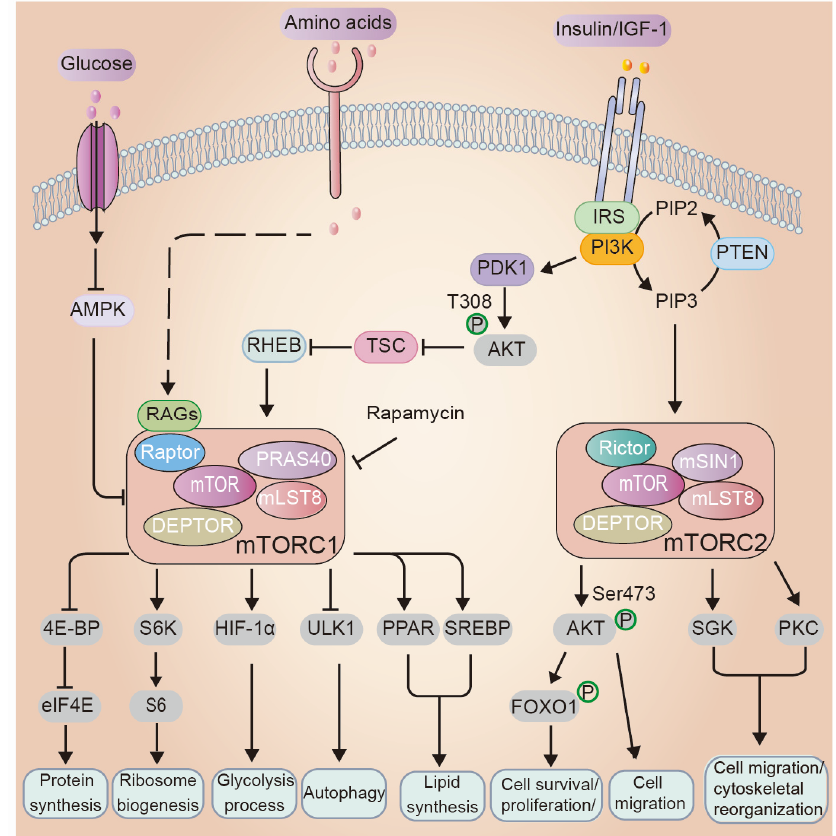
Figure 2. Overview of mTOR signaling network. Amino acids, growth factors, oxygen and the cellular energy are the major inputs inducing mTORC1 activity. Upon stimulating by the growth factors such as insulin/insulin-like growth factor 1 (IGF-1), the receptor tyrosine kinase phosphorylates PI3K and subsequently activates PI3K-PDK1-AKT signaling cascades. The activated AKT phosphorylates tuberous sclerosis complex 2 (TSC2) and inhibits TSC1 and TSC2 complex formation. This further inactivates TSC1/2 and releases Ras homolog enriched in brain (RHEB), which in turn binds and activates mTORC1. The activated mTORC1 phosphorylates downstream effectors, such as S6K and 4E-BP1, governing several crucial cellular processes including protein synthesis, lipid metabolism, ribosome biosynthesis and autophagy. Additionally, in response to amino acids, RAS-related GTP binding proteins (RAGs) form obligate heterodimers, which then bind RAPTOR to stimulate mTORC1 activity. The upstream regulators of mTORC2 activation are less well defined but supposed through PI3K. Activated mTORC2 phosphorylates the AGC kinase family members, mainly protein kinase C (PKC), serum glucocorticoid-regulated kinase (SGK) and AKT, which primarily regulate cell metabolic processes, survival, migration and cytoskeletal